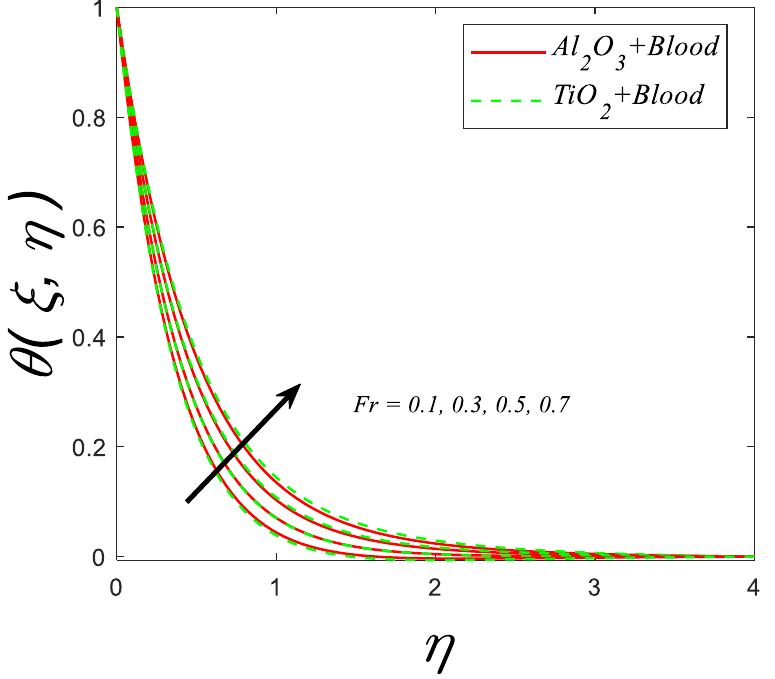
Figure 7. Temperature profile for deviating estimations of Fr . When M = 0.3, Q = 0.1, ϑ = π Rd = 0.1, Gr = 0.1, Pr = 21, Ec = 0.1, λ = 0.5, β = 1.5, φ =